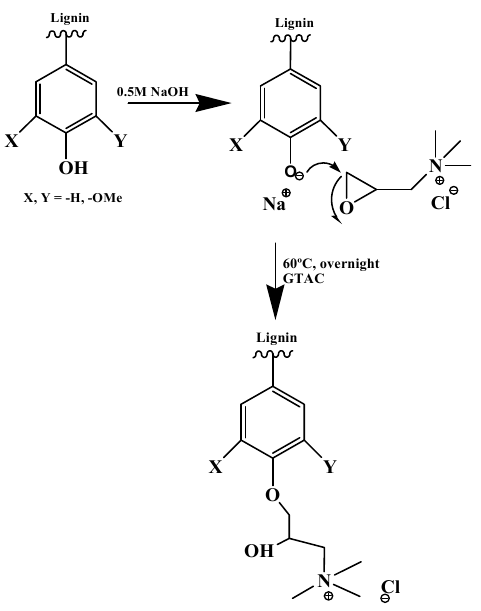
Figure 13. Reaction scheme for lignin derivatization with GTAC under alkaline conditions (Taken from reference [67] with permission of the European Polymer Journal).